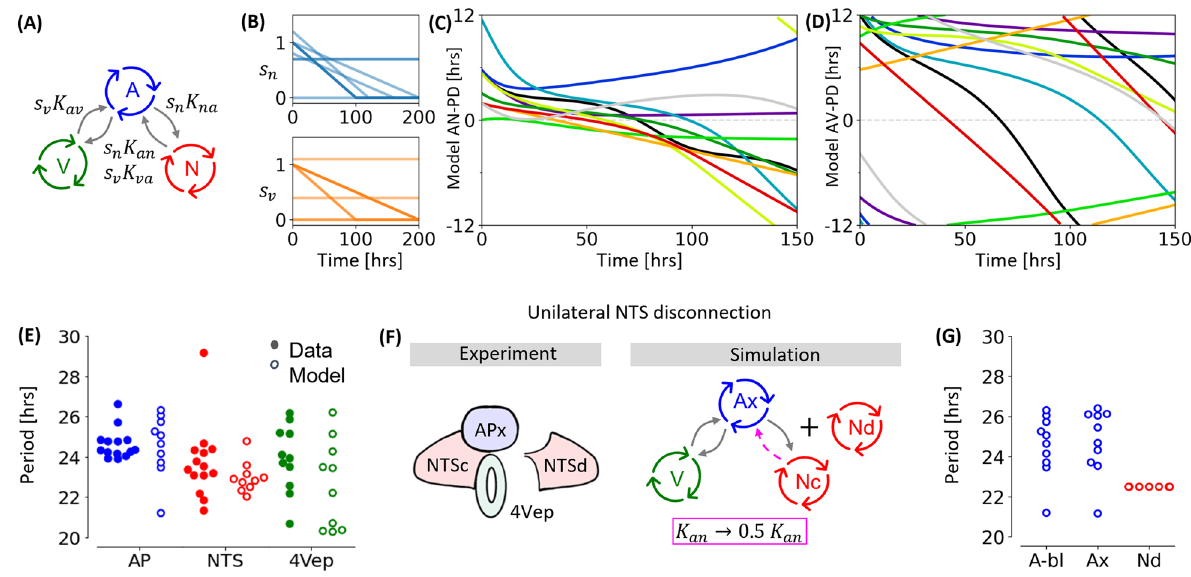
Figure 4. AP-NTS-4Vep coupled oscillator with decaying coupling parameters simulates multiple features of the data. ( A ) Network topology of the model. Coupling control parameters s n ( t ) and s v ( t ) are specific for AP-NTS and AP-4Vep interactions respectively. ( B ) Time course of the global coupling parameters. ( C ) and ( D ): Simulated AN-PD and AV-PD traces, respectively, with initial conditions taken from the data. ( E ) Periods of the three biological and simulated oscillators across a baseline experiment or simulation. ( F ) Schematic illustration of the surgical disconnection experiment performed in 30 and its in silico analogue. ( G ) Results of the simulated NTS disconnection experiment for oscillators observed